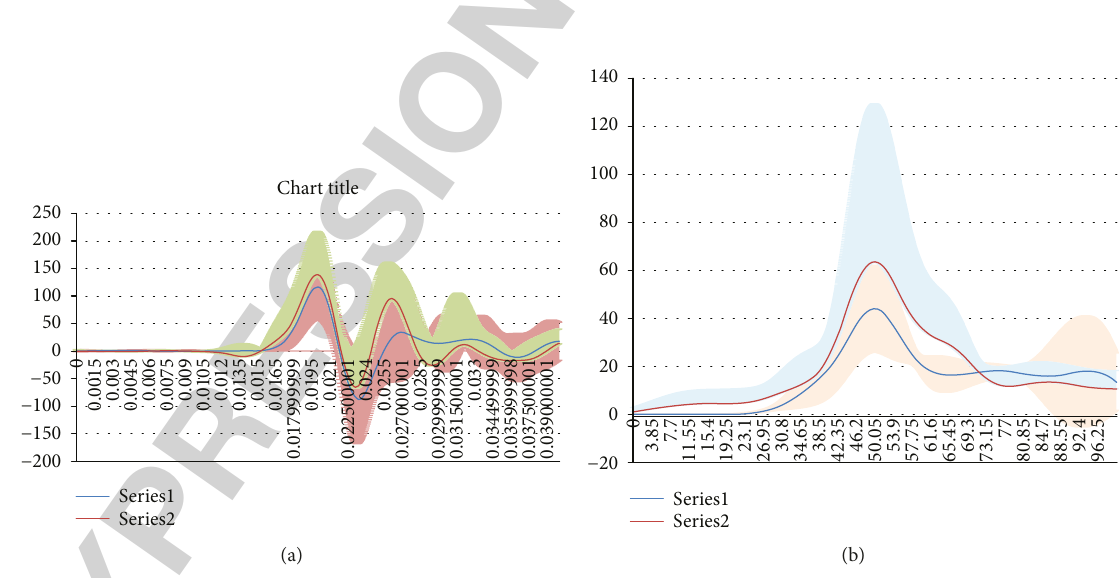
Figure 4: The corridor curves of the acceleration and pressure. The corridor of the acceleration (a) and the pressure (b) was showed, in which the acceleration and the pressure were indicated with di ff erent colors, with black referring to the data in group I and red in group